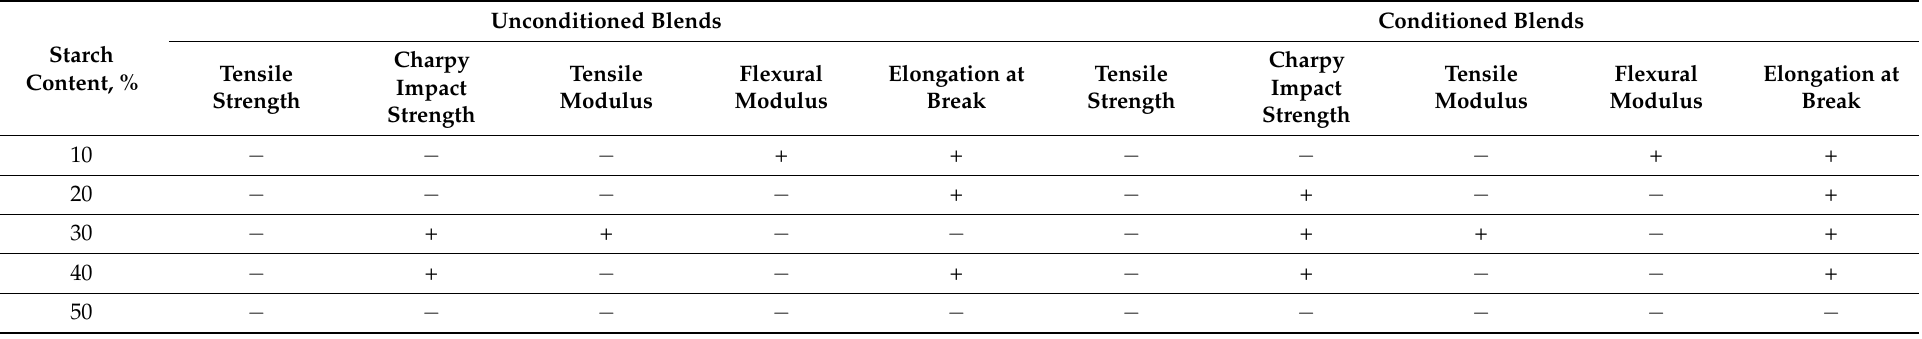
Table 3. Effects on mechanical properties of castor oil-based additive (“+”: positive change relative to an additive-free blend of a suitable composition; “ − ”: negative change relative to an additive-free blend of a suitable composition).